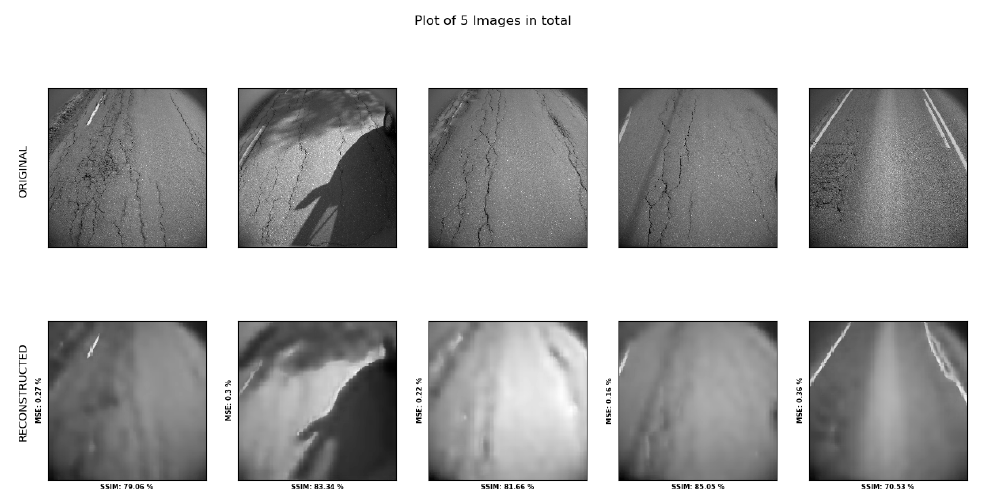
Figure 19. Model performance of reconstruction visualized, with the bottom road showing the reconstructed images and the top row showing the original image. This involves tests of no-, low-, and medium-damage classes.